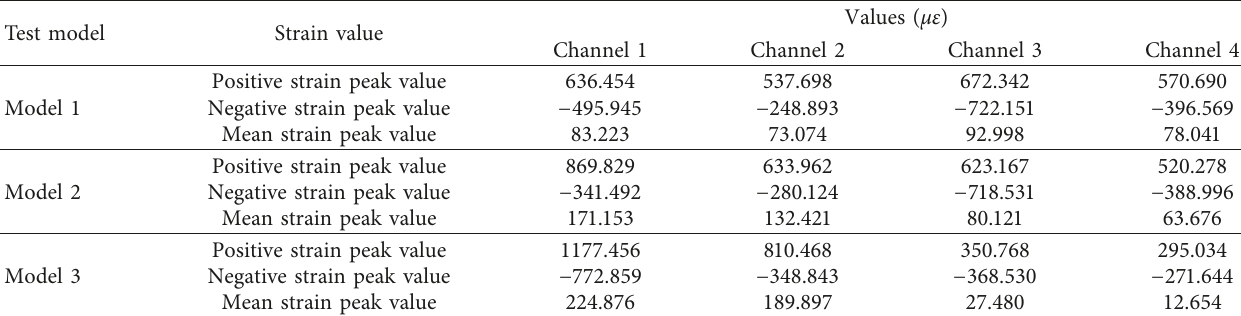
Figure 4: Sketches of three different blasting models and the strain gauge arrangement: (a) #1 test model, (b) #2 test model, and (c) #3 test model. Table 2: Strain values for three different blasting